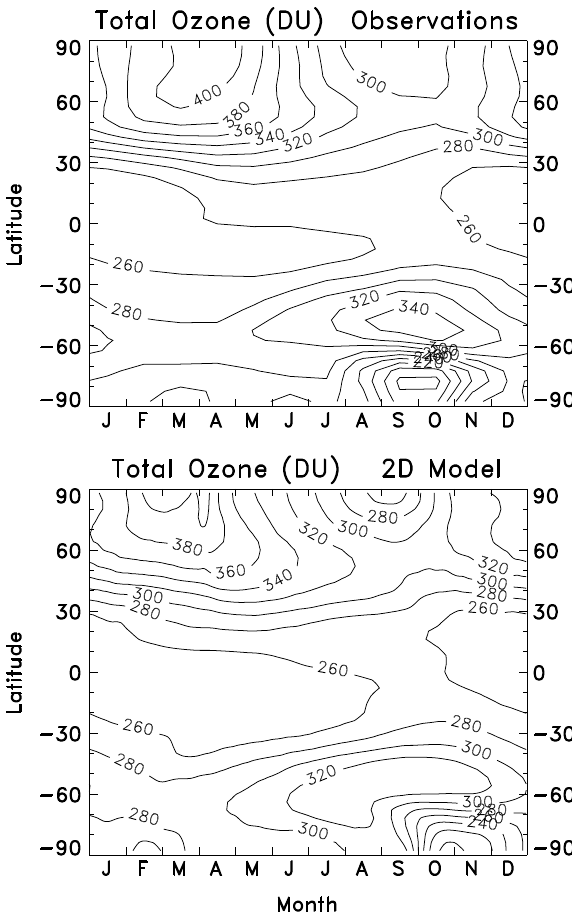
Fig. B9. Latitude-height cross-sections of annually averaged ozone Figure B9. Latitude-height cross-sections of annually averaged ozone expressed in Dobson Units per Fig. B10. Month-latitude cross-sections of total column ozone av- Figure B10. Month-latitude cross-sections of total column ozone averaged over 1988–2002 from expressed in Dobson Units per kilometer. The observations (top eraged over 1988–2002from ground-based observations (top panel, kilometer. The observations (top panel) are from the climatology compiled by McPeters et al. (2007) panel) are from the climatology compiled by McPeters et al. (2007) ground-based observations (top panel, updated from Fioletov et al., 2002) and 2-D model simulation updated from Fioletov et al., 2002) and 2-D model simulation (bot- covering the time period 1988–2002. Also shown are the 2-D model covering the time period 1988–2002. Also shown are the 2-D model simulation averaged over 1988– tom panel). The contour interval is (bottom panel). The contour interval is 20 DU. simulation averaged over 1988–2002 (middle panel), and the dif- 2002 (middle panel), and the difference, model minus observations (bottom panel). For the top and ference, model minus observations (bottom panel). For the top and middle panels, the contour interval is 2DUkm − 1 and includes middle panels, the contour interval is 2 DU km − 1 and includes the 3 contour level. For the bottom panel, the 3 contour level. For the bottom panel, the contour interval is ± 1 DU km − 1 , and dashed contours indicate negative differences. the contour interval is ± 1DUkm − 1 , and dashed contours indicate negative differences. 74